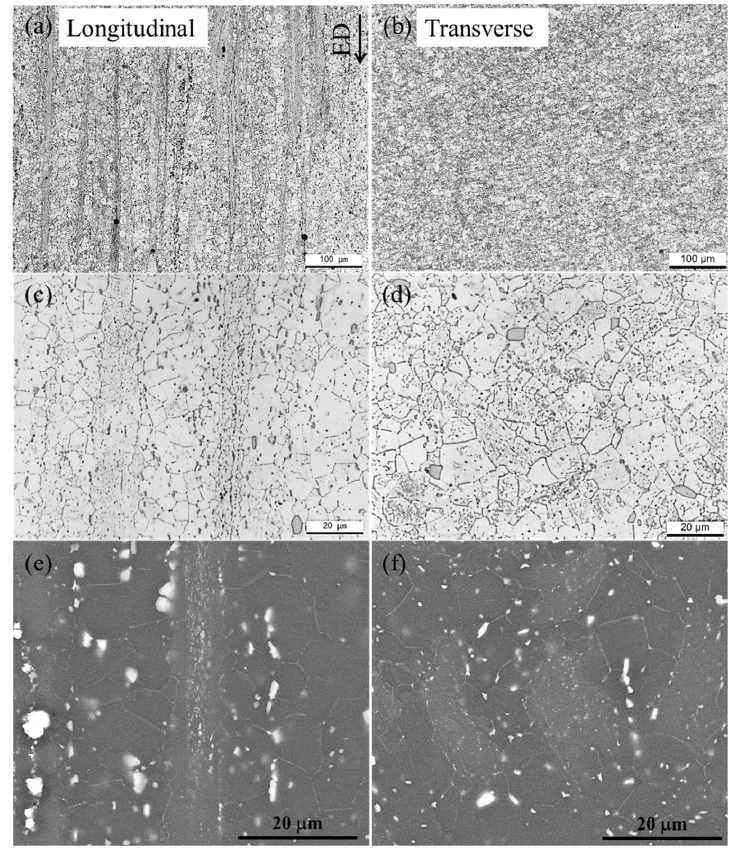
Figure 2. Typical microstructures of the as-extruded Ex-1 WE43 alloy with partially dynamic recrystallization: ( a , c , e ) longitudinal direction, i.e., extrusion direction (ED), and ( b , d , f ) transverse direction.